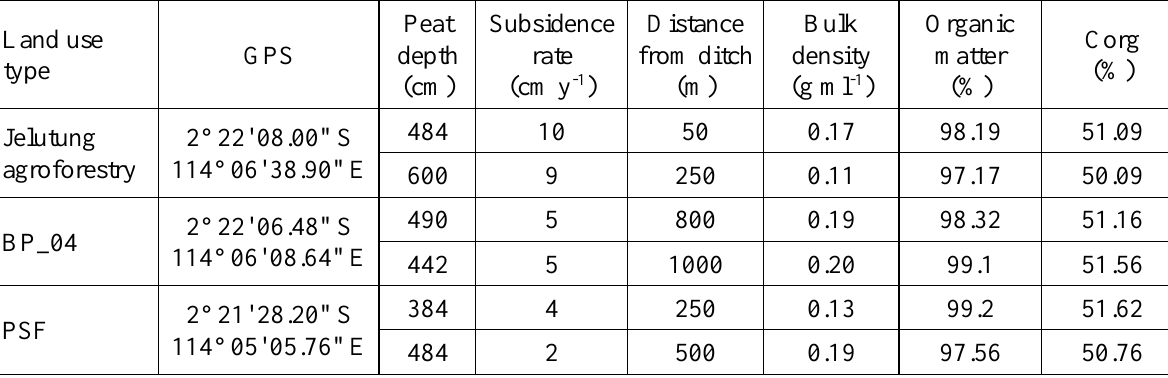
Table 3. Peat depths and subsidence rates measured in 2013 in the example plots of jelutung agroforestry ( D. polyhylla +rambutan+ S. balangeran ), peatland (PSF) that burned in 2004 (BP_04) and unfelled/unburnt PSF at Tumbang Nusa (Central Kalimantan). The bulk density, organic matter and organic carbon (Corg) of peat under different land uses was measured in the depth range 0–10